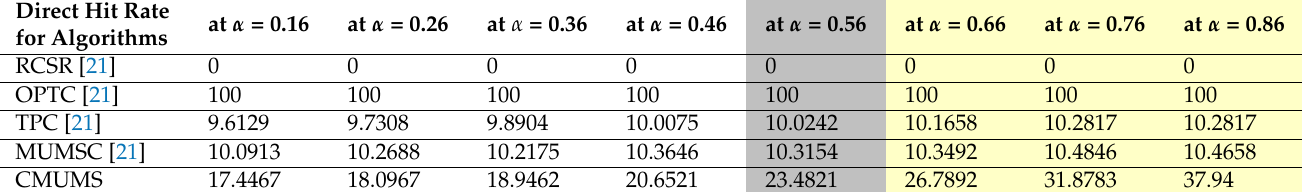
Table 4. Direct hit rate at different α for comparing the referenced algorithms in [21] with CMUMS at Q = 250